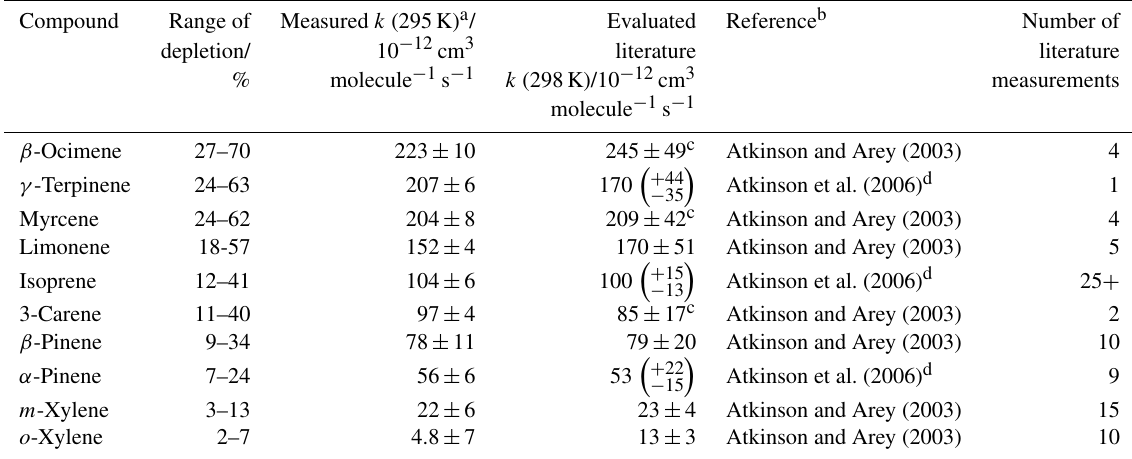
Table 1. Results of relative rate experiments, with literature data, for each VOC in Mixture 1, ordered by measured k value. Compound Range of Measured k (295K) a /